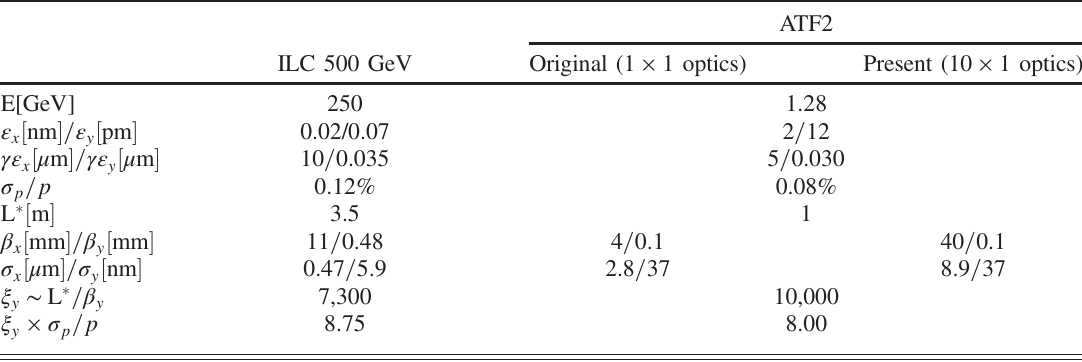
TABLE I. Beam and optics parameters for the ILC and ATF2 final focus beam lines.